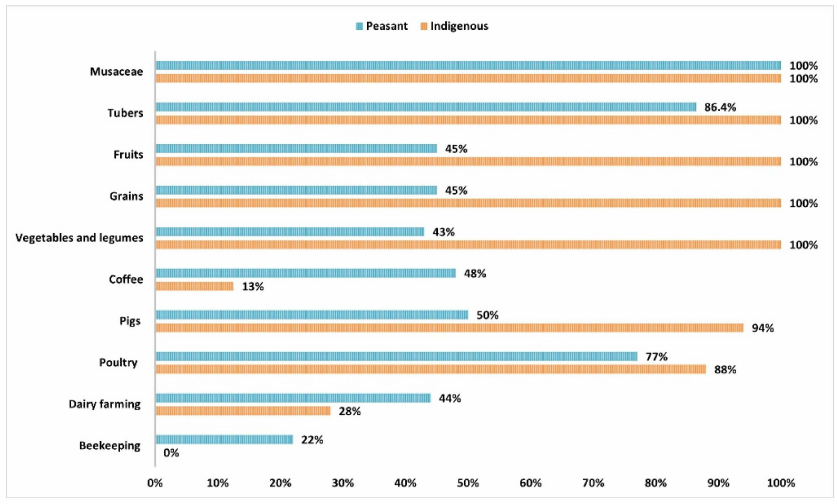
Figure 6. Product diversification in FF farms. Source: generated by the